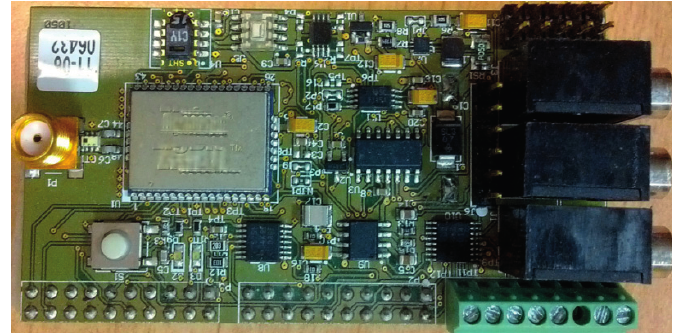
Figure 4. iLive node. ILive is equipped with the AVR ATmega1281 microcontroller (128 KB FLASH, 8 KB RAM), one temperature sensor, one light sensor, one air sensor, one humidity sensor, three soil moisture decagon sensors [16] and four soil moisture watermark sensors